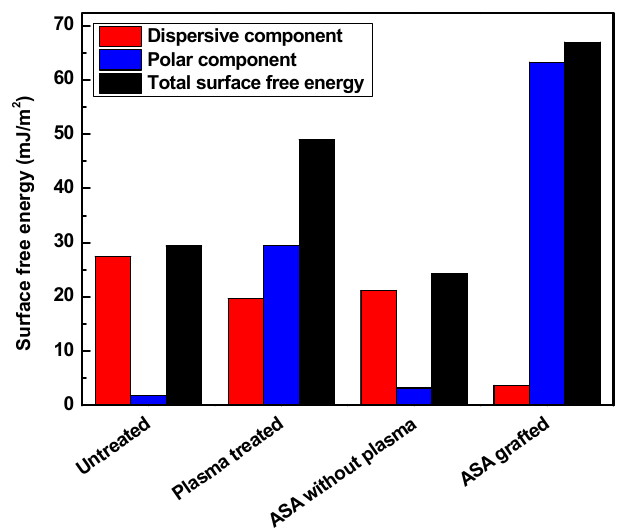
Figure 4. The surface free energy of LDPE samples.